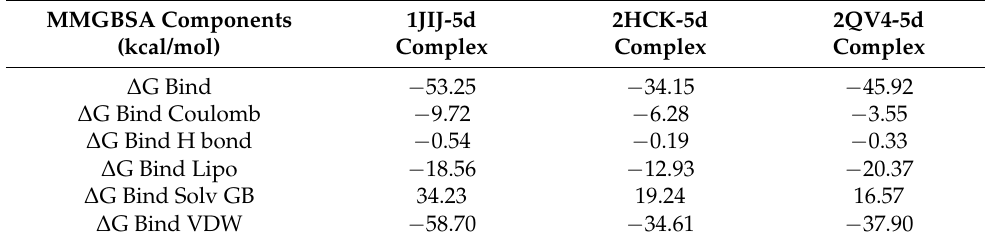
Table 6. The Prime MMGBSA (ensemble-averaged) binding free energies (kcal/mol) of compound 5d with targeted proteins during the 100 ns MD